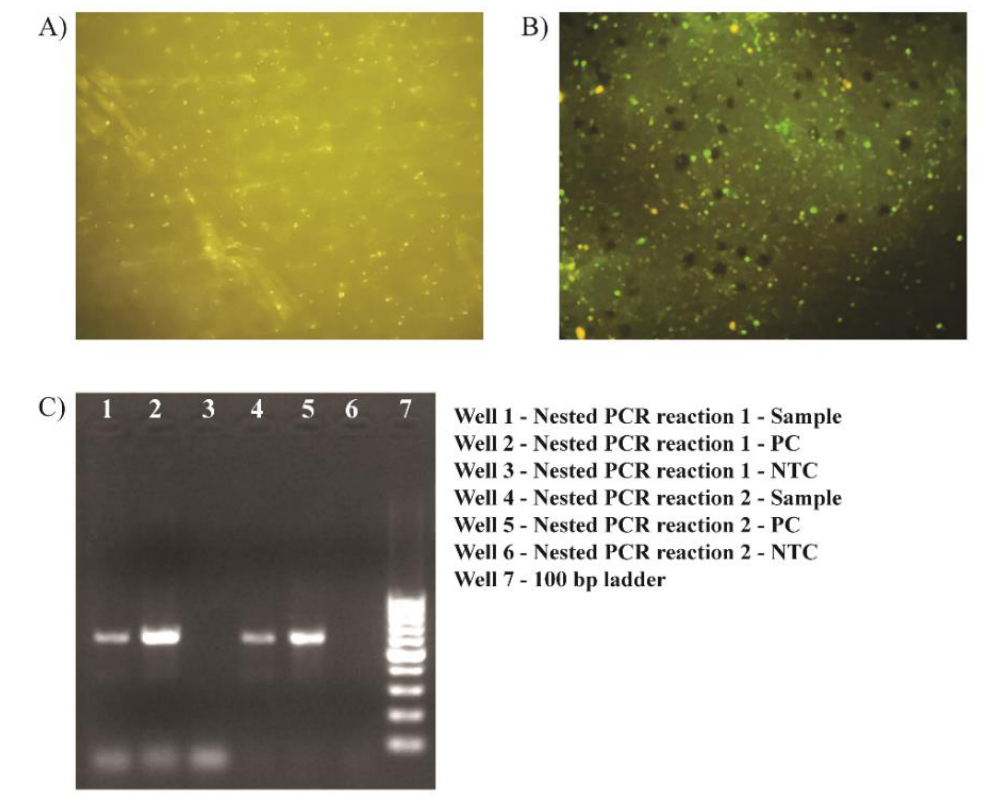
Figure 1. Fluorescence micrograph (400 × magnification) of direct Fluorescence Antibody Test (FAT) performed on impression smear of the brain sample of ( A ) normal mouse, and ( B ) cerebellum of the suspected rabid stray dog. ( C ) Documented gel image of nested RT-PCR for pan-lyssavirus RNA showing characteristic bands at ~606 bp (first round) and ~582 bp (second round) with the valid positive control (PC) and no template controls (NTC).